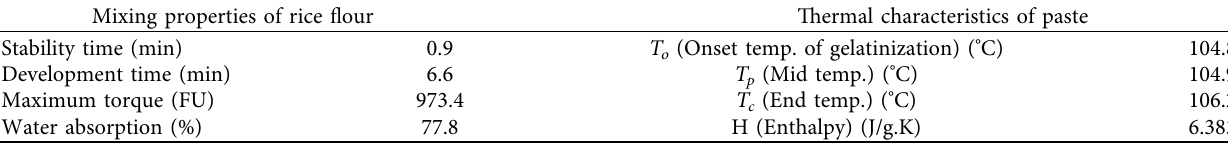
Table 1: Mixing and thermal characteristics of flour and paste. Mixing properties of rice flour